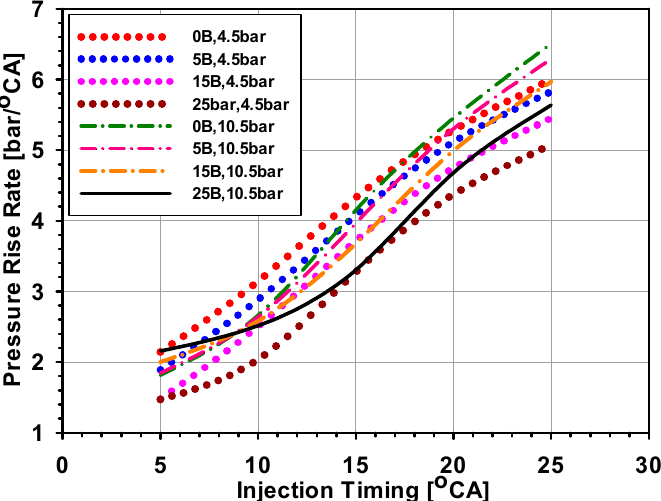
Figure 4. Variation of pressure rise rate with injection timing for diesel and butanol blends at BMEP = 4.5 bar and 10.5 bar.